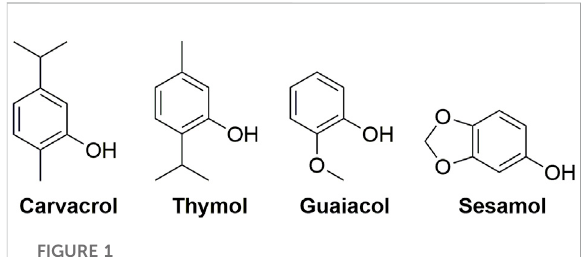
FIGURE 1 The structures of botanical active components of carvacrol, thymol, guaiacol, and sesamol.